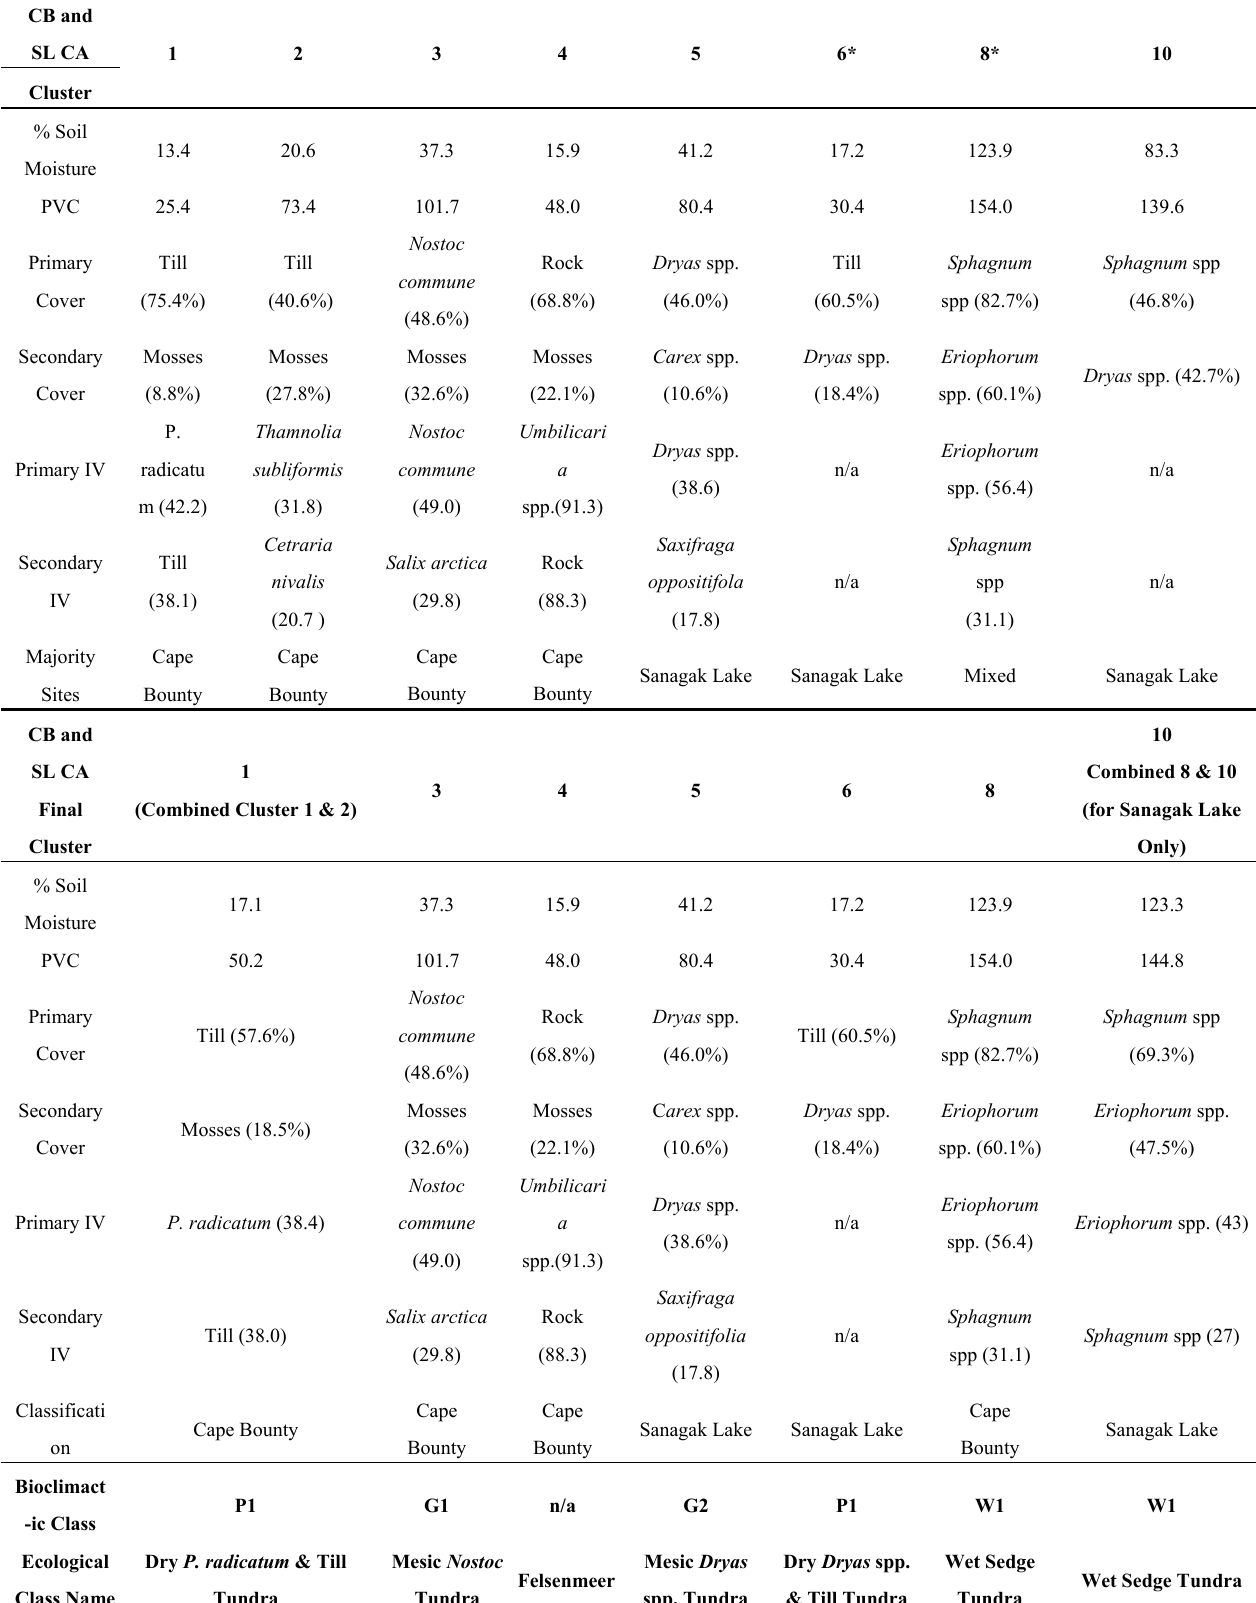
Table 2. Ecological descriptions of the final CA clusters (post MRPP and